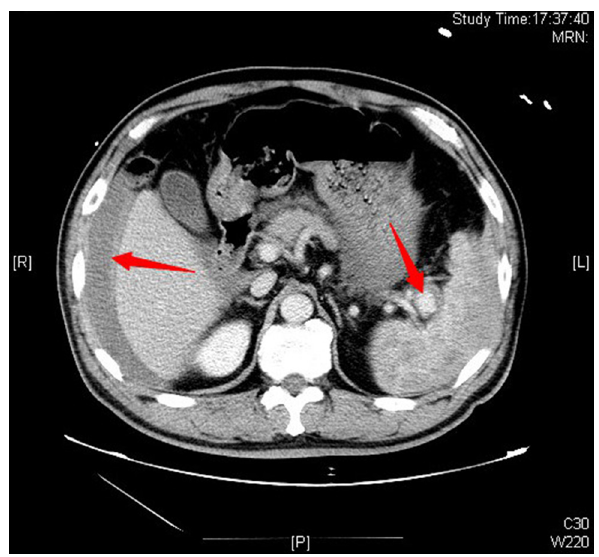
Figure 1: Contrast - enhanced CT of the abdomen showed perihepatic hemorrhage and splenic aneurysm ( arrows ) .